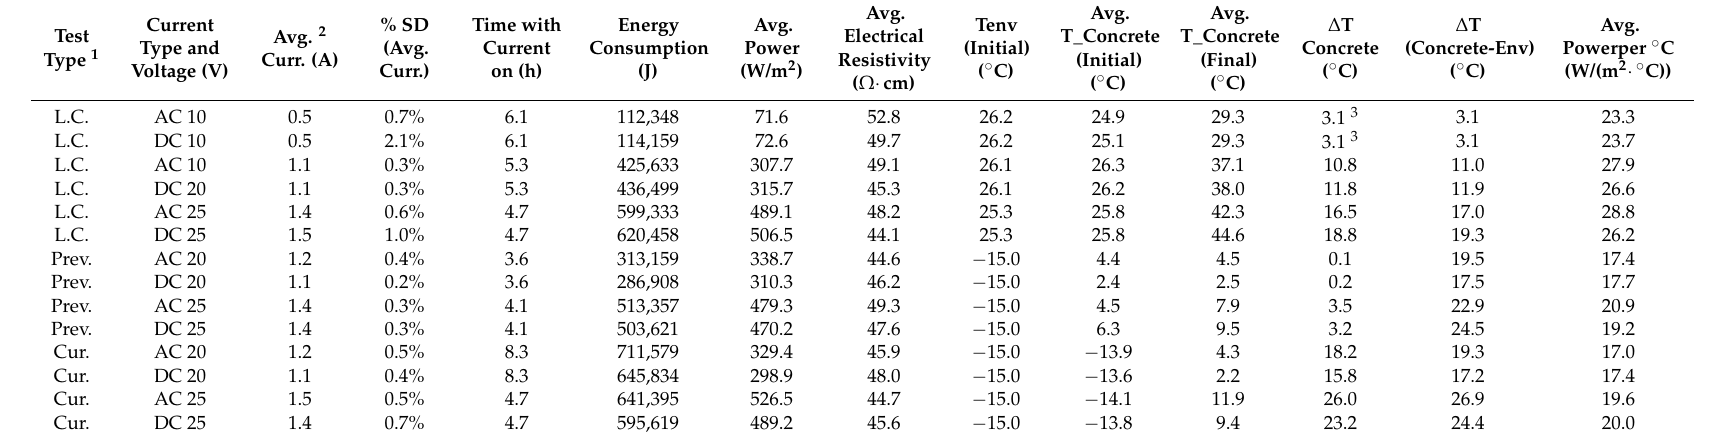
Table 3. Summary of the results obtained in all